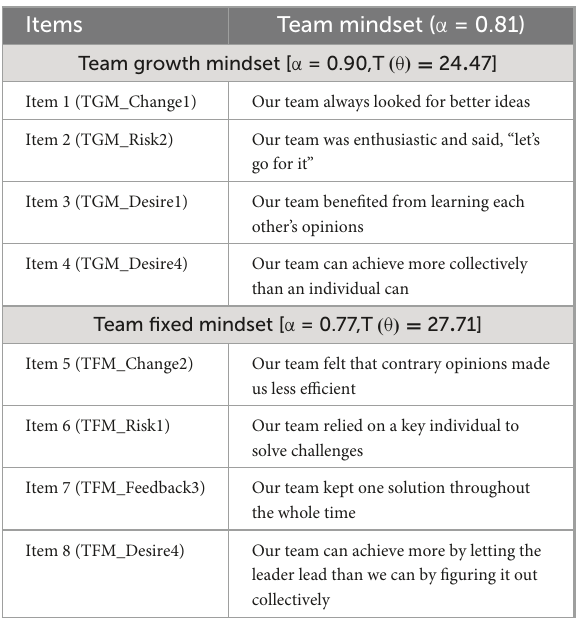
For the gender group, two datasets of Study 1 and Study 2 were combined, and the factorial invariance between males ( N = 390) and females ( N = 575) was examined.